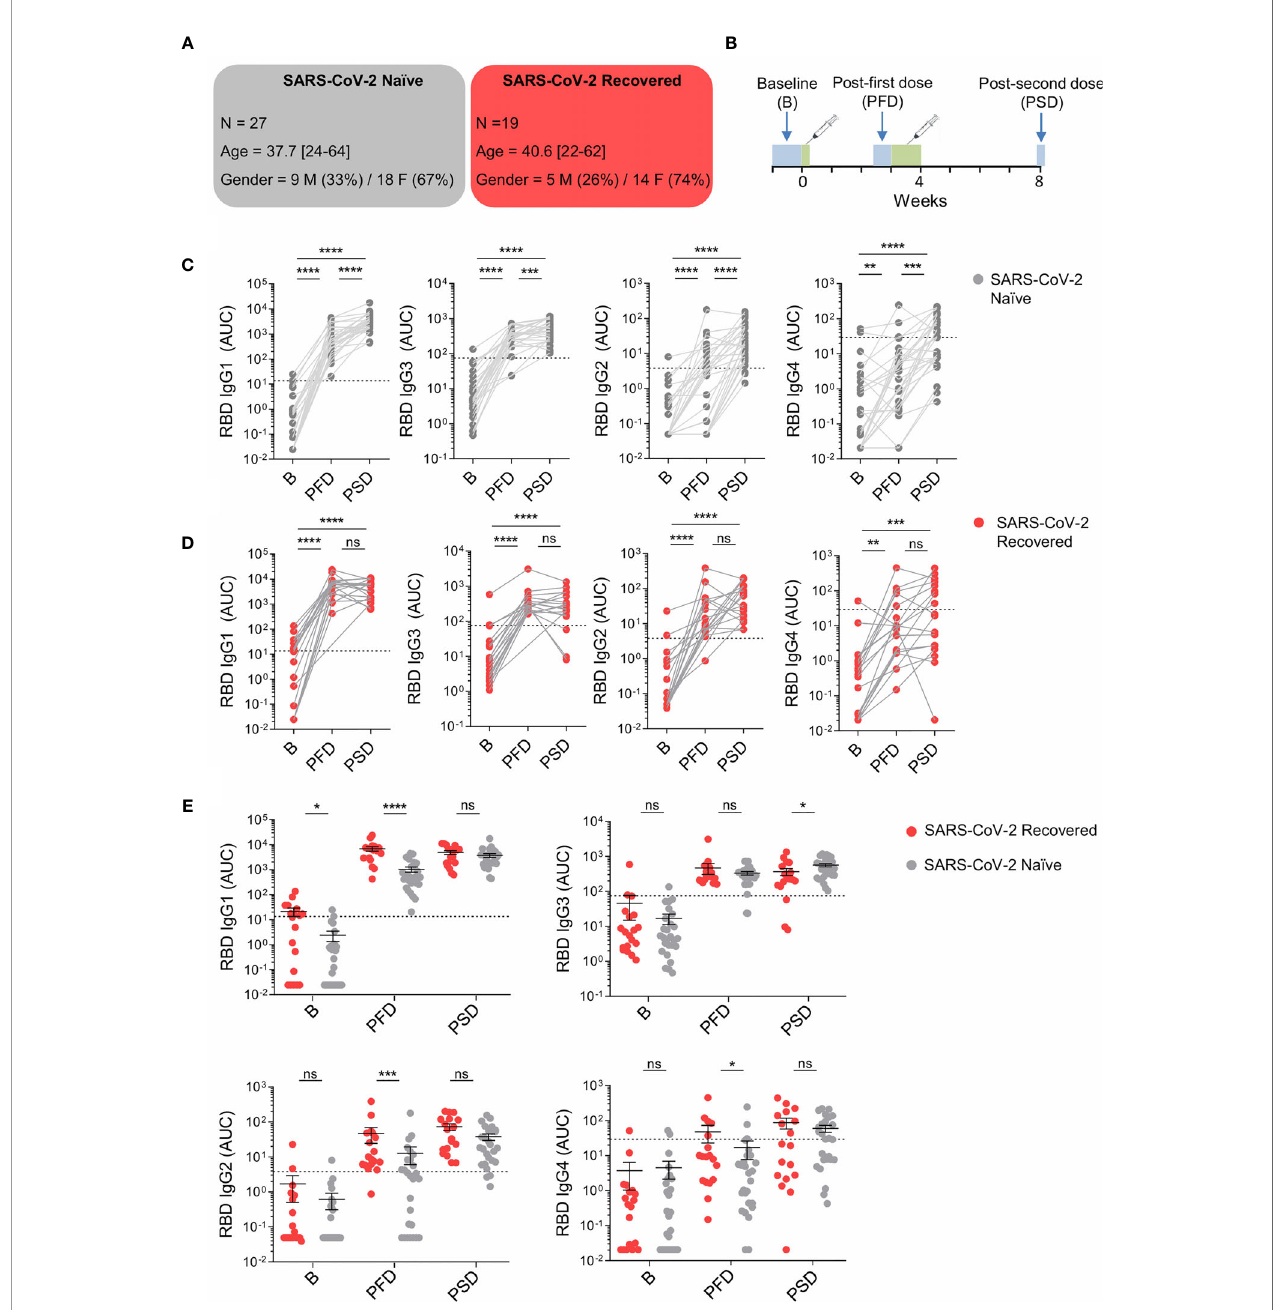
FIGURE 1 | mRNA-1273 vaccination induces differentpatternof WTRBD-speci fi c IgG subclass responses in SARS-CoV-2 naïveandrecovered individuals. (A) Schematic diagram of the cohortcharacteristics. M,male. F, female. (B) Schematicdiagram of the studytimeline. Sera were collected at 3 time points: pre-vaccinebaseline, 2/3weeks post the fi rst dose (PFD) and1 month post thesecond dose (PSD). Range of days per time pointisindicated with a box. (C) Area under the curve(AUC)for each of the WT RBD-speci fi c IgG subclasses analyzed from SARS-CoV-2 naïve individuals overtime. (D) AUC for each of the WTRBD-speci fi c IgG subclasses analyzed from SARS-CoV-2 recovered individualsovertime. (E) AUCfor each of theWTRBD-speci fi c IgG subclasses analyzed from SARS-CoV-2 naïve and recovered individualsovertime depicted inthe same graph. Sera from SARS-CoV-2 naïveindividualsat baseline wereused to establish negative thresholdvalues de fi ned as the naïve AUC mean plus 2 times thestandard deviation of themean. Barsrepresent mean ± standard error mean (SEM). Dashed line indicates negative threshold. Data arepresented as individual dots. Wilcoxon matched pairs test was performed to compare timepoints. Two-tailed Mann-Whitney U test was performed to compareSARS-CoV-2 naïve andrecovered individuals(ns, not signi fi cantP > 0.05, *P< 0.05, **P < 0.01, ***P < 0.001, and****P < 0.0001).SARS-CoV-2 naïve, n=27; SARS CoV-2